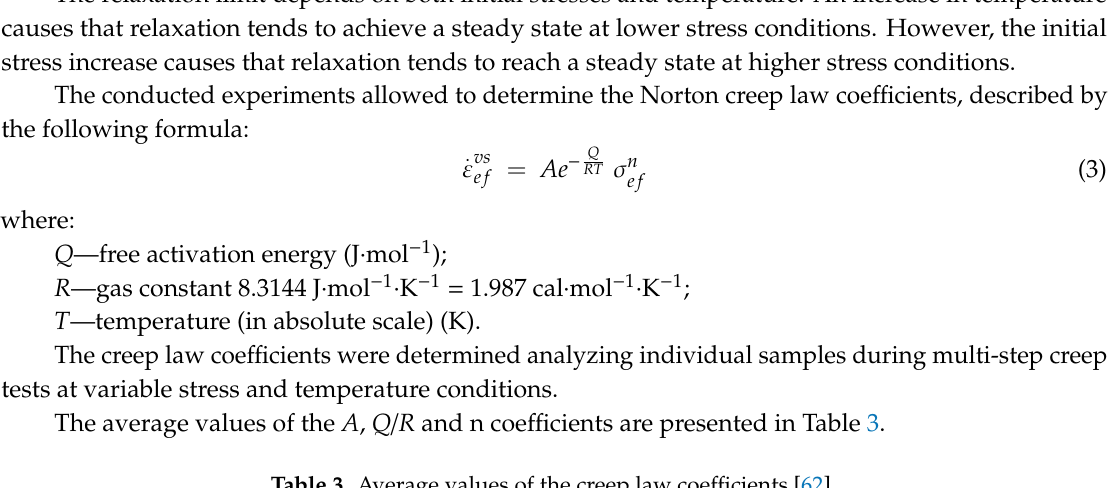
Figure 21. The Brown and Red Zuber unit samples’ relaxation curves at the initial axial stress of 30 MPa (according to [62]).